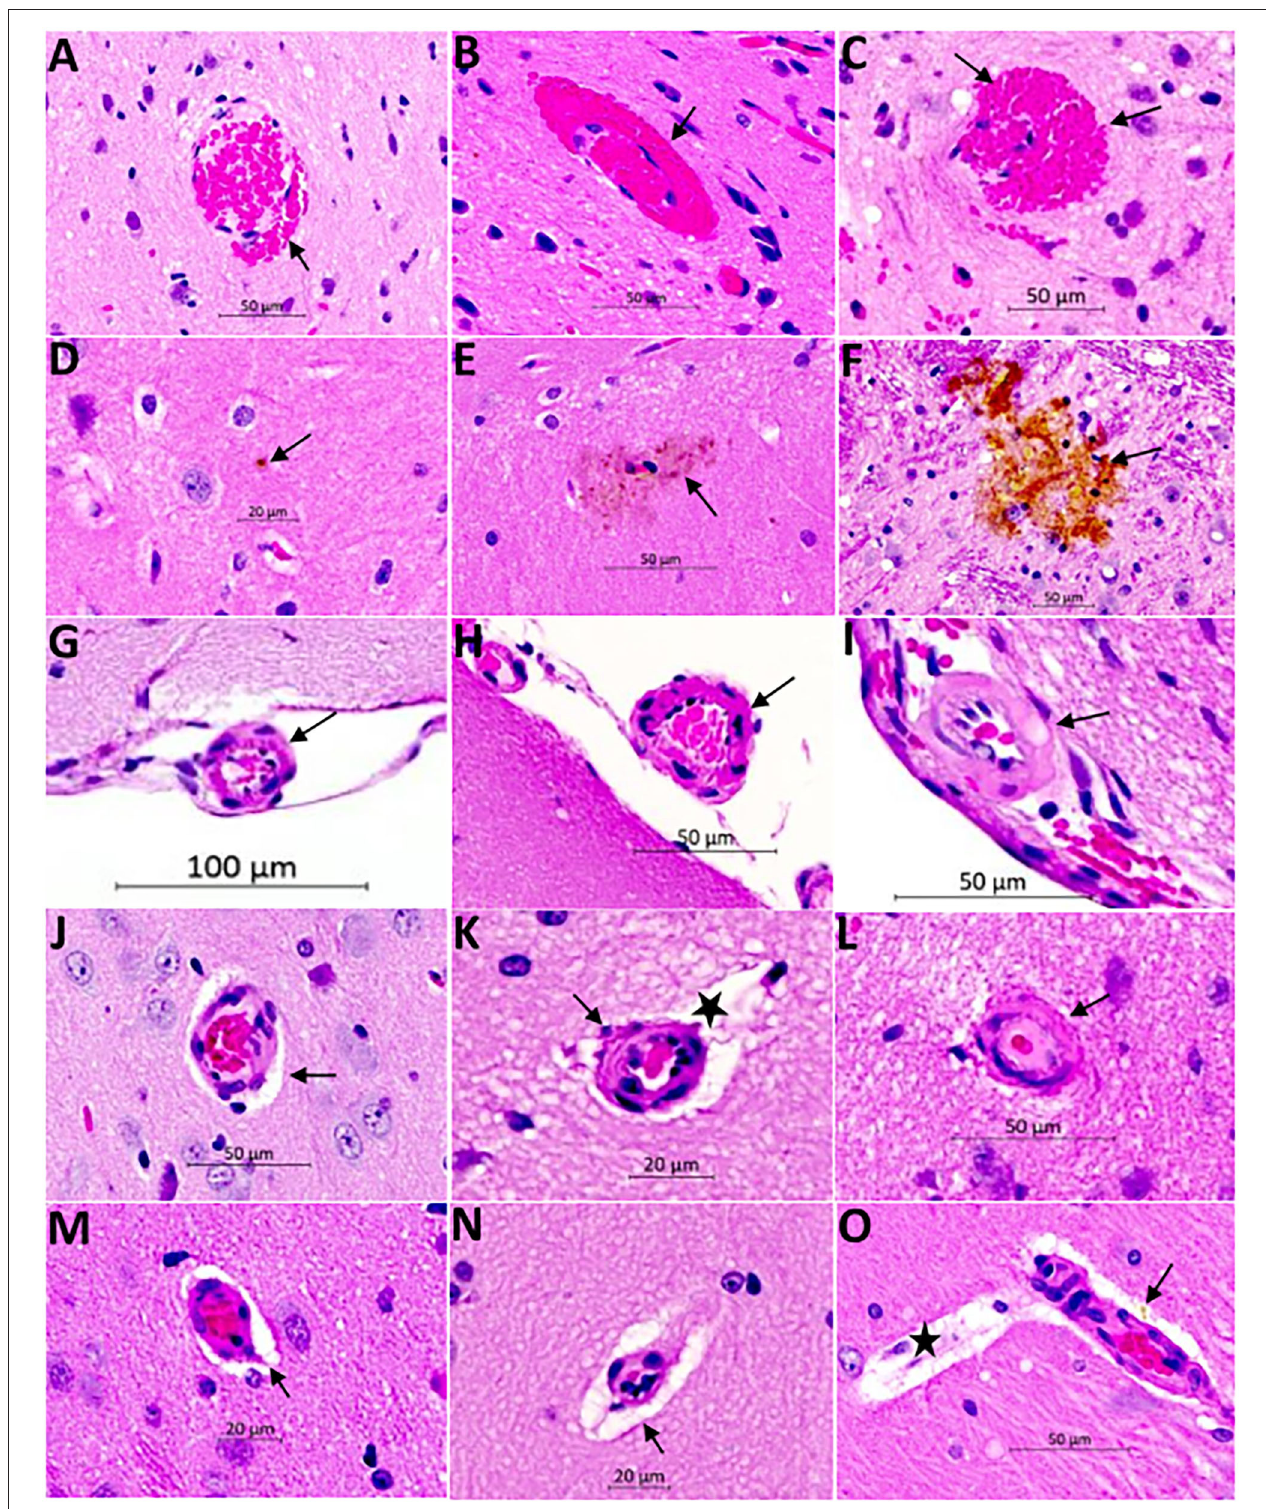
FIGURE 6 | Hematoxylin and Eosin (H&E) staining of the brain of SHRSP demonstrates CSVD lesions including extravasation of red blood cells and microbleed formation (A–C) , hemosiderin deposition (D–F) , thickening and hyalinization of vessel wall (G–L) , and enlargement of the perivascular spaces (M–O) . Sections were obtained from the mid sagittal brain area at the level of the dorsal and ventral hippocampus and images were captured at (20X) magnification. Early red blood cells extravasation is encountered consistently at 16 weeks of age [arrow in (A) ] which increases in size with age at 24 weeks [arrow in (B) ] and 32 weeks [arrows in (C)